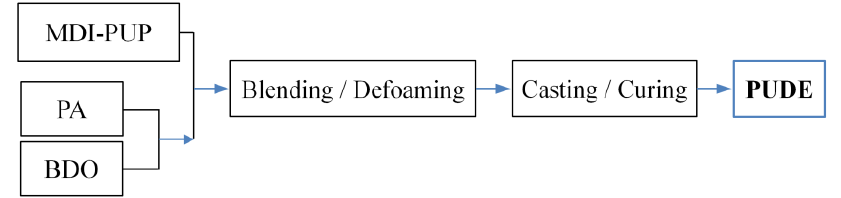
Figure 2. Preparation Flow of PUDE.